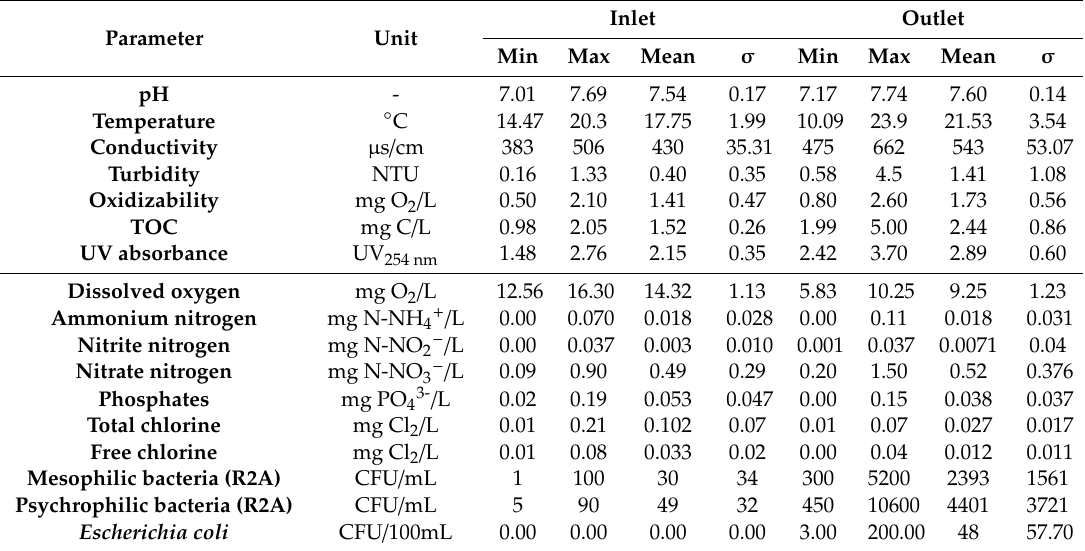
Table 2. Inlet and outlet water quality characteristics (N = 26).